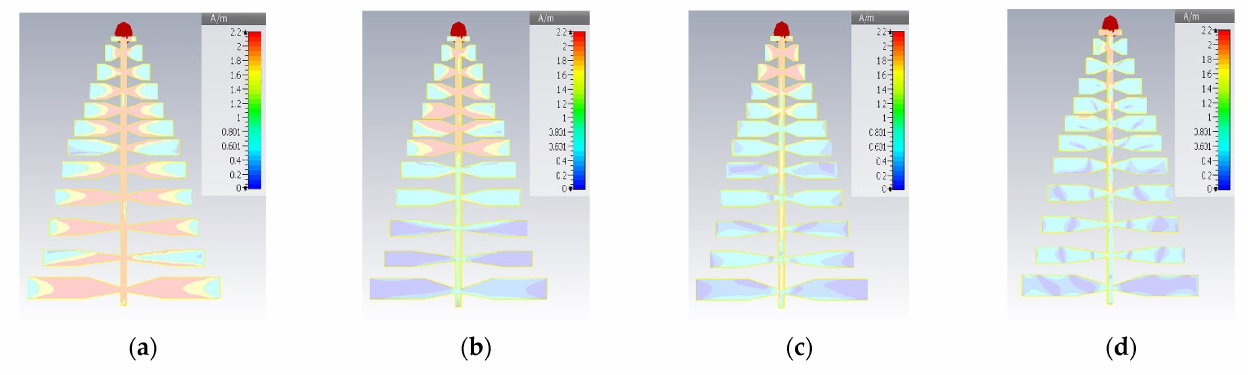
Figure 13. Surface current distribution at: ( a ) 0.7 GHz; ( b ) 1.2 GHz; ( c ) 2.2 GHz; ( d ) 4.5